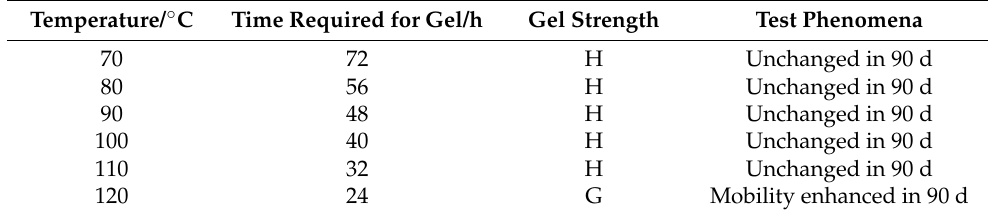
Table 2. Temperature resistance of plugging agent. Temperature/ ◦ C Time Required for Gel/h Gel Strength